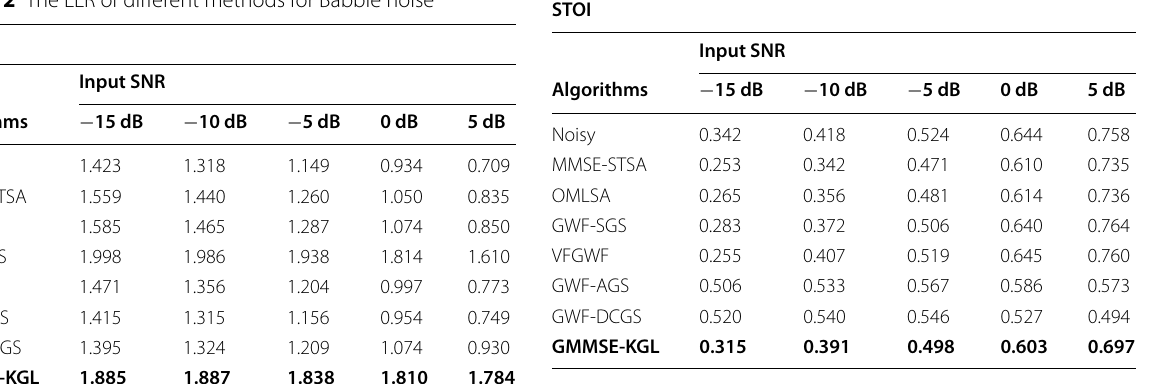
Table 12 The LLR of different methods for Babble noise